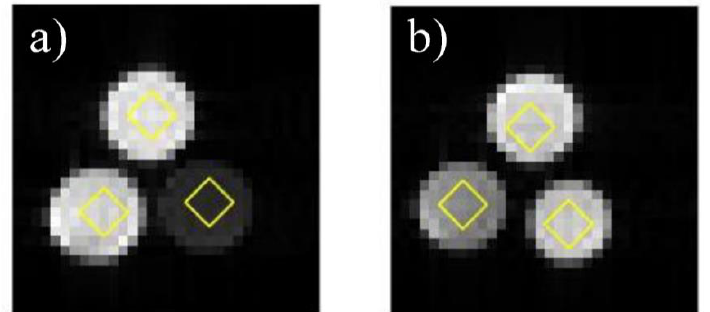
Figure 2. DW images acquired by using the PGSE sequence ( ∆ = 35 ms and b = 0). ( a ) The first Sephadex series: G25–50 (bottom right), G50–50 (bottom left), and G75–50 (top). ( b ) The second Sephadex series: G50–50 (bottom left), G50–80 (bottom right), and G50–150 (top). The rhombus- shaped ROIs indicate the regions used to calculate the mean parameter values.